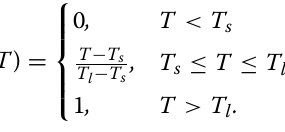
the only way to increase its value is an irreversible movement along the black diagonal line in Fig. 2. For all other locations in the diagram a reversible horizontal movement is possible. With these considerations a temperature-based interpolation procedure for any material parameter can be